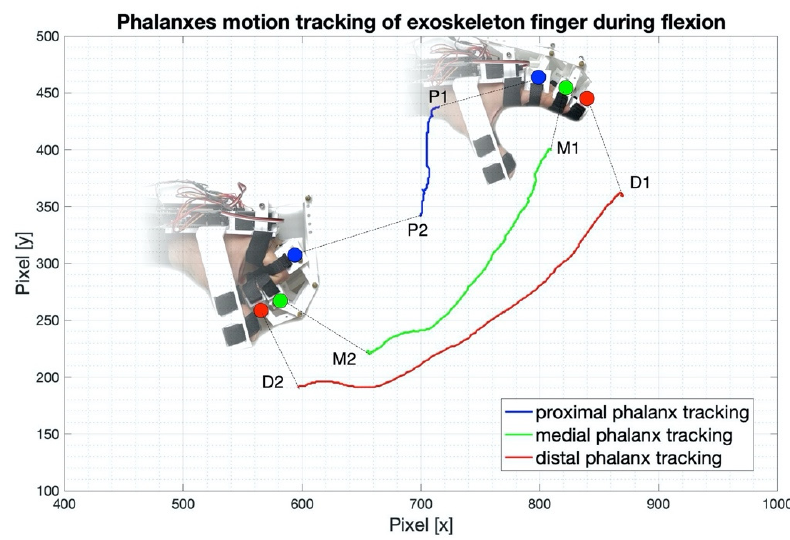
Figure 10. Trajectories described by each phalanx of the index finger (depicted in different colors) of the hand exoskeleton during flexion movement in a real scenario.